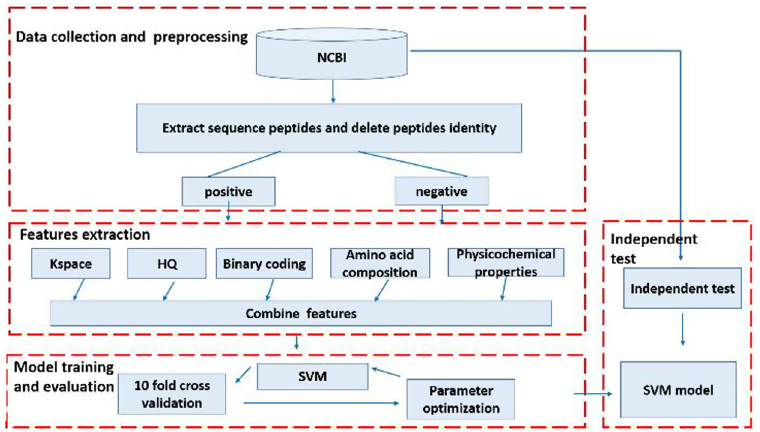
Figure 3. Schematic showing the workflow used to develop our method. KSAAP: k-space amino acid pairs; HQI: high-quality indices; BE: Binary encoding; AAC: Amino acid composition; AAindex: physiochemical amino acid properties; SVM: support vector machines; NCBI: National Center for Biotechnology